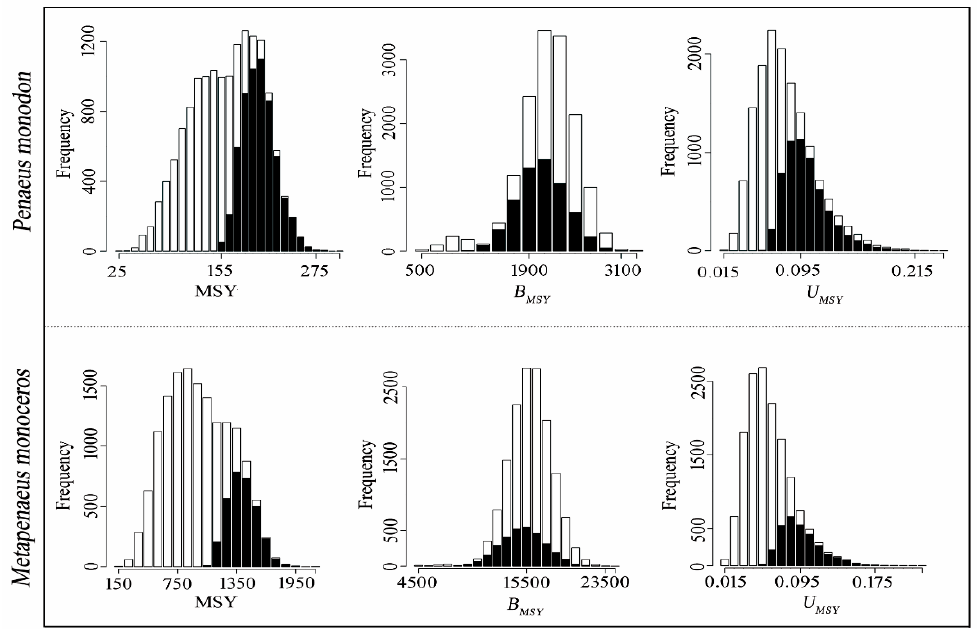
Figure 4. Estimated reference points by the DB-SRA model from accepted (black) and rejected (white) model runs.